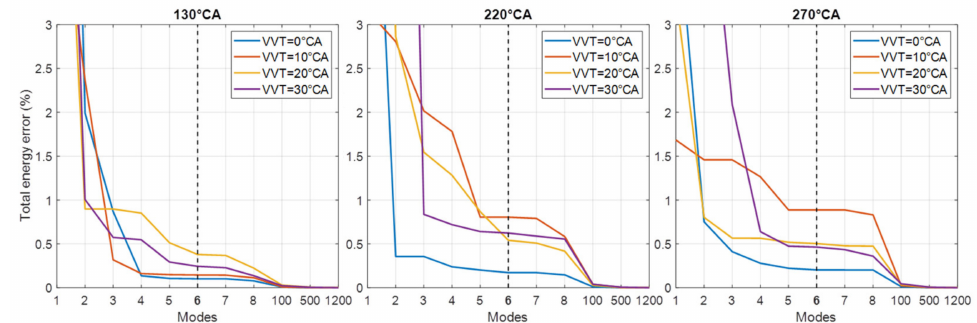
Figure 9. Total energy error between the mean and reconstructed field with K modes; θ = 130, 220 and 270 ◦ CA.